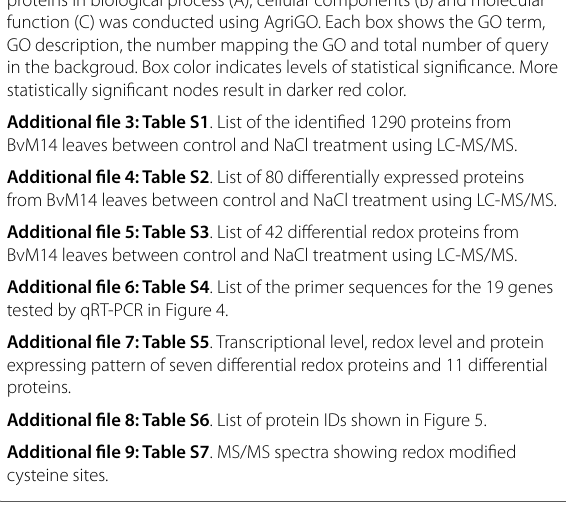
Additional file 8: Table S6 . List of protein IDs shown in Figure 5. Additional file 9: Table S7 . MS/MS spectra showing redox modified cysteine